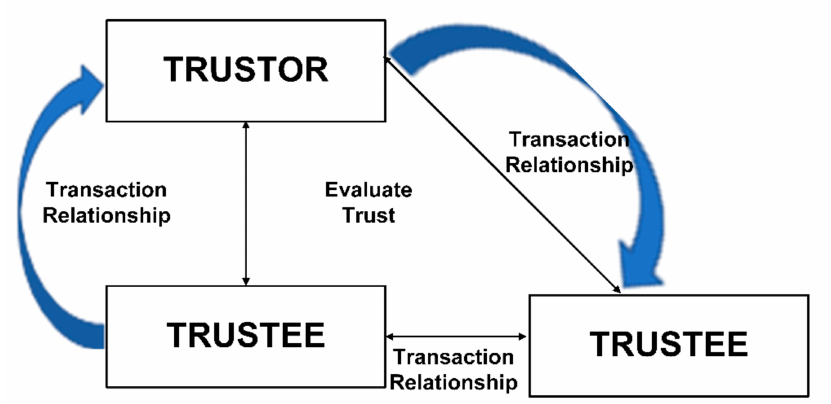
Figure 3. Relationship between trustor and trustee